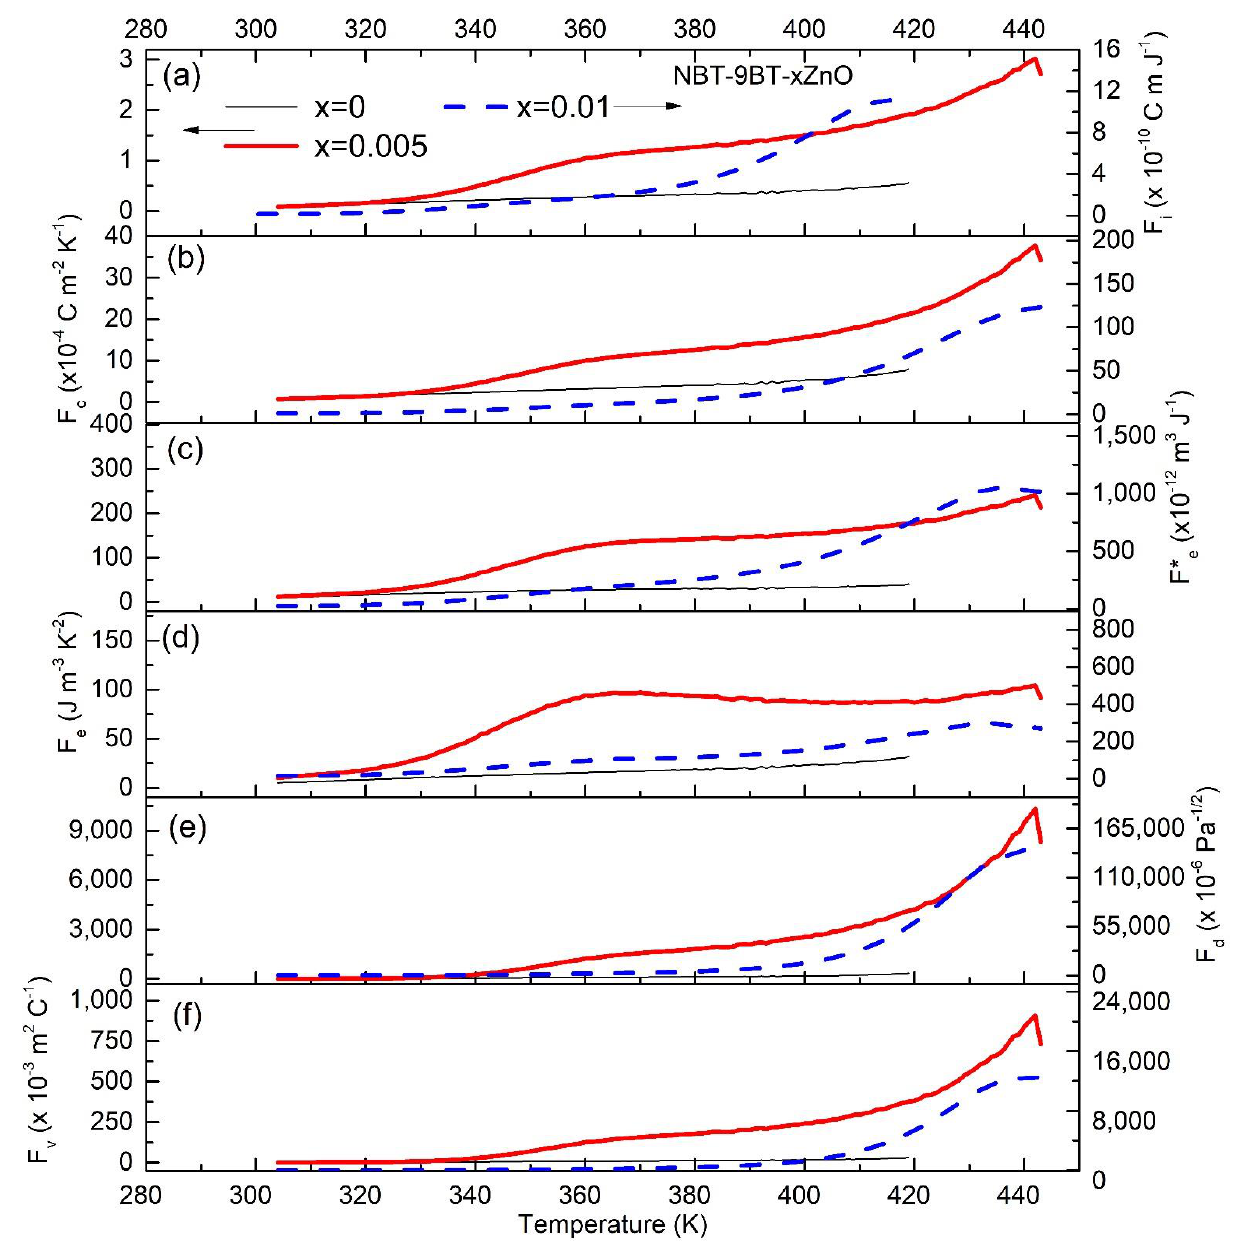
Figure 7. Pyroelectric figures of merit versus temperature plots of NBT-9BT-xZn (x = 0.005 and 0.01) for high ( a ) current responsivity 𝐹 𝑖 , ( b ) the pyroelectric figure of merit 𝐹 𝑐 , energy harvesting ( c ) 𝐹 𝑒∗ and ( d ) 𝐹 𝑒 , ( e ) detectivity 𝐹 𝑑 and ( f ) the voltage responsivity 𝐹 𝑣 . The maximum value of FOMs ( 𝐹 𝑒∗ ) and ( 𝐹 𝑒 ) obtained are 1033 × 10 −1 2 m 3 J − 1 and 281 J m − 3 K − 2 for NBT-9BT-0.01Zn, 1363 × 10 −1 2 m 3 J − 1 and 753 J m − 3 K − 2 for NBT-6BT-0.01Zn, which are much higher than that of undoped NBT-6BT and NBT-9BT, respectively. Similar be- havior is observed for 𝐹 𝑑 and 𝐹 𝑣 , where the Zn-doping increases the FOM at room tem- perature, as seen in Figures 6e,f and 7e,f. Zn-doping results in an increase in the tempera- ture-independent behavior from 303 – 350 K for NBT-6BT to 303 – 380 K for NBT-6BT- 0.001Zn. However, the FOMs after the tenth heating cycle showed a better temperature- independent behavior for Zn-doped NBT-6BT and NBT-9BT (Figures A1 and A2). Table